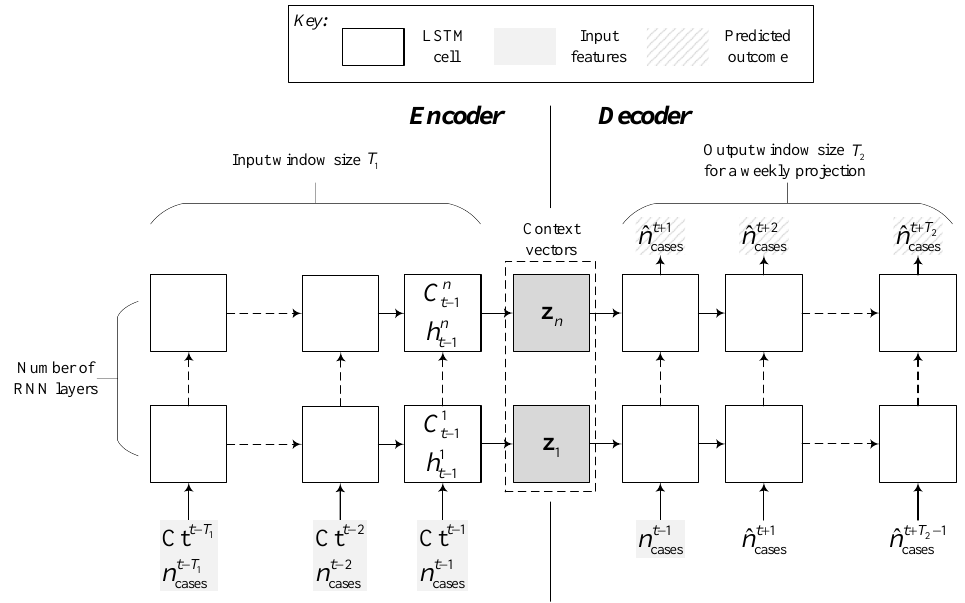
Figure 2. Structure of the sequence-to-sequence (S2S) model used for now-casting the weekly number of cases. The left side of the network is the encoder that uses past information on Ct and the number of cases to create context vectors used to initialize the hidden and cell states of the decoder LSTM